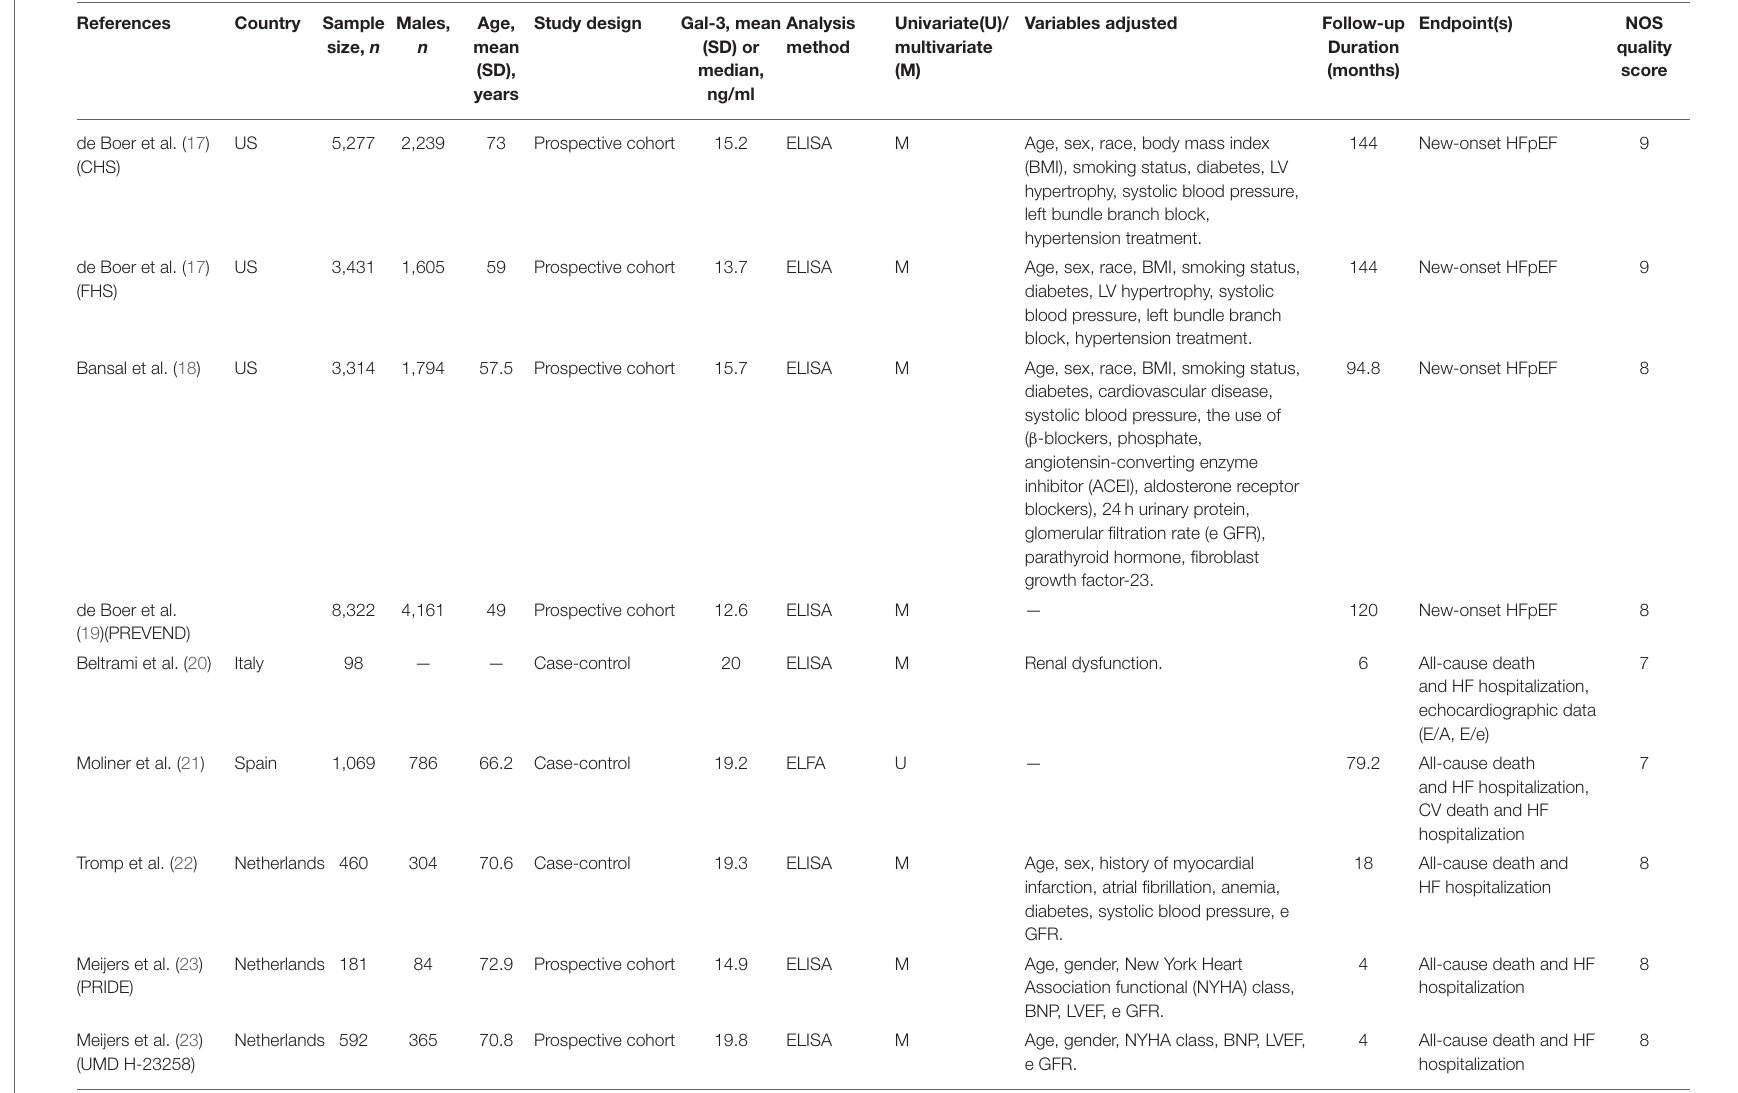
TABLE 1 | Baseline characteristics of the 27 selected